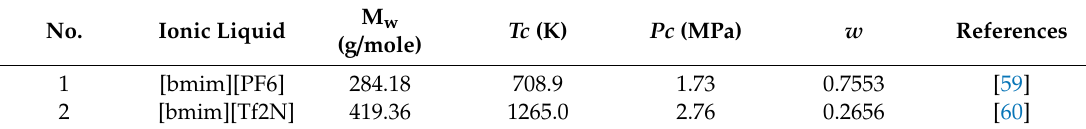
Table 5. Thermodynamic properties of [bmim][TF2N] and [bmim][PF6]